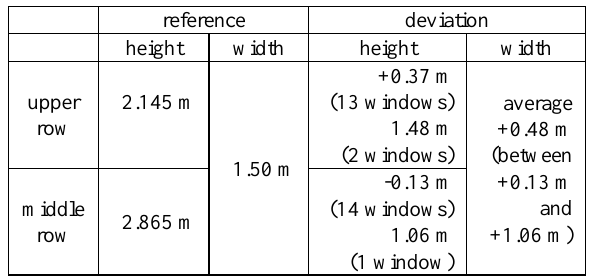
Table 1. Evaluation of window size (rectangular